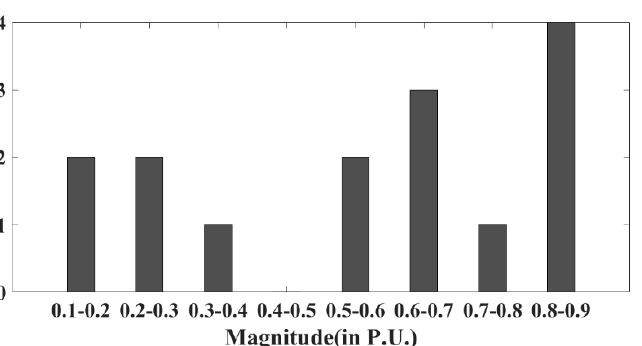
Figure 11. Assessment and comparison of voltage sag per year versus magnitude range of bus 10.